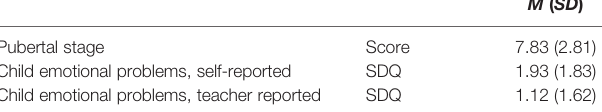
TABLE 1 | Characteristics of the study sample ( n = 2298) at the time of the 11 – 12 years follow-up measurements.